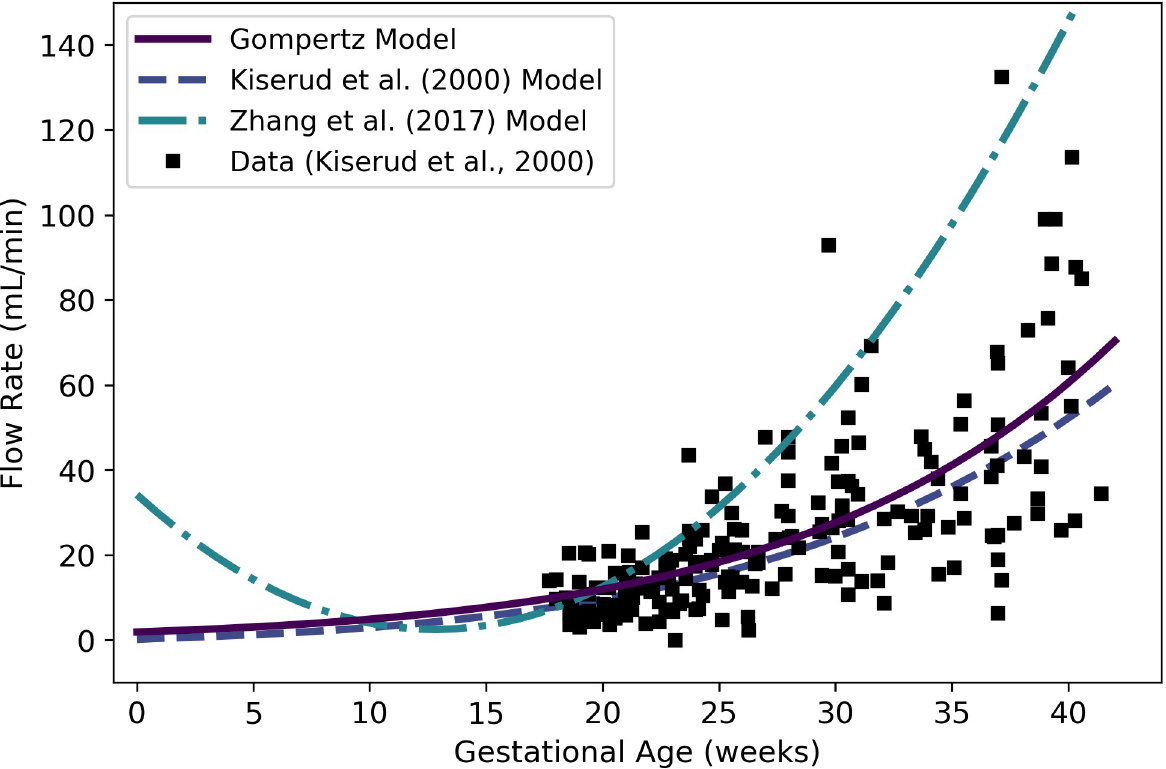
Fig 26. Fetal blood flow through the ductus venosus vs. gestational age. The Gompertz model (solid line) given by Eq 51 was selected as the most parsimonious model in our analysis. The model of Kiserud et al. [40] was calibrated using the same data set [40] used by us, whereas the model of Zhang et al. [32] was calibrated using a different compiled data